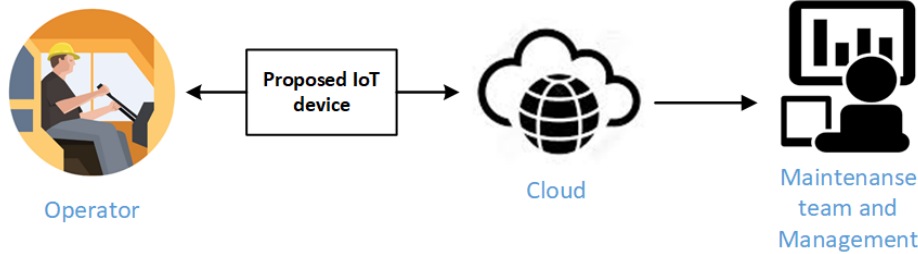
Figure 2. Cloud platform as the center of data flow.